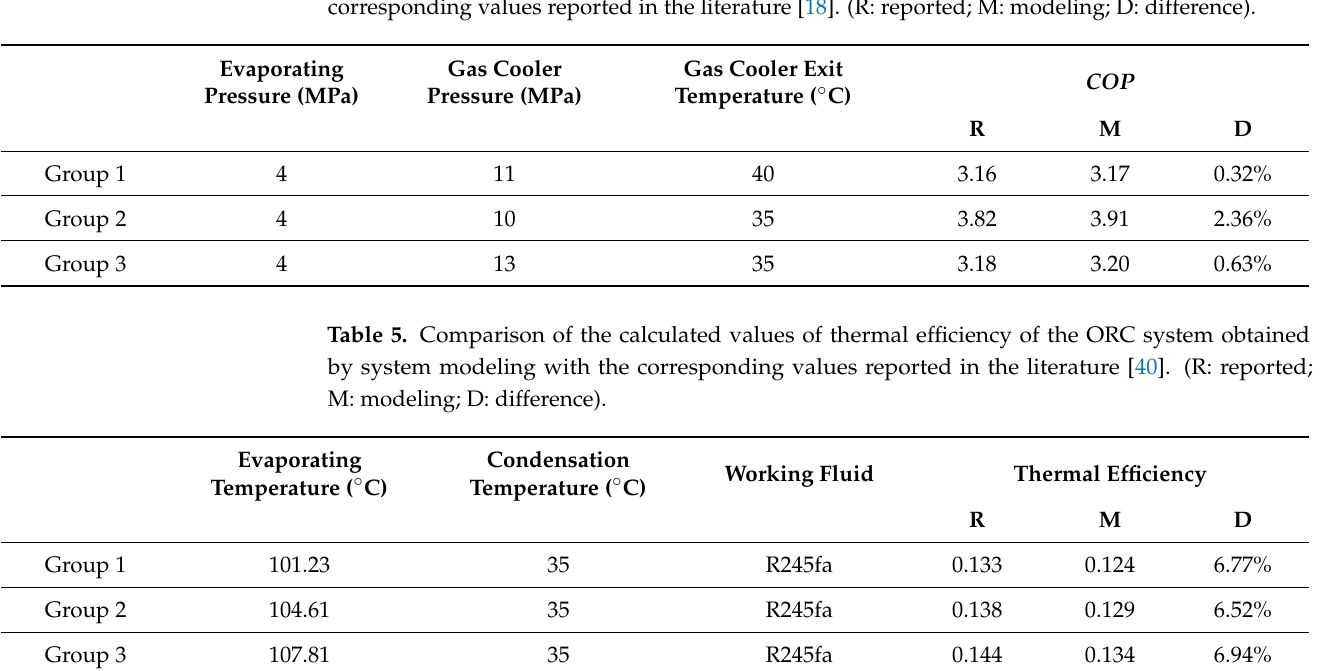
Table 4. Comparison of the COP values of the CO 2 system obtained by system modeling with the corresponding values reported in the literature [18]. (R: reported; M: modeling; D: difference).